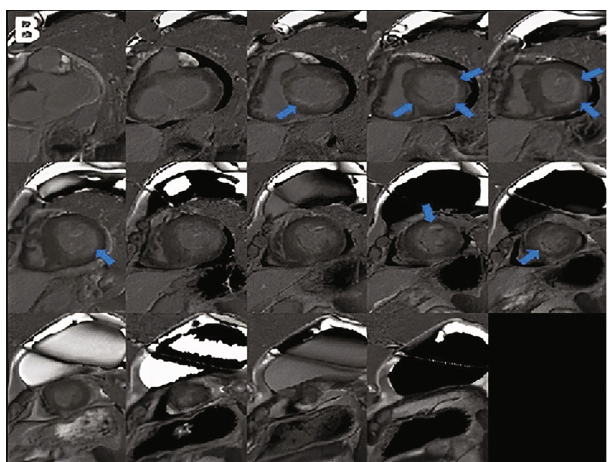
Figure 3: CMR revealed patchy midmyocardial and subendocardial